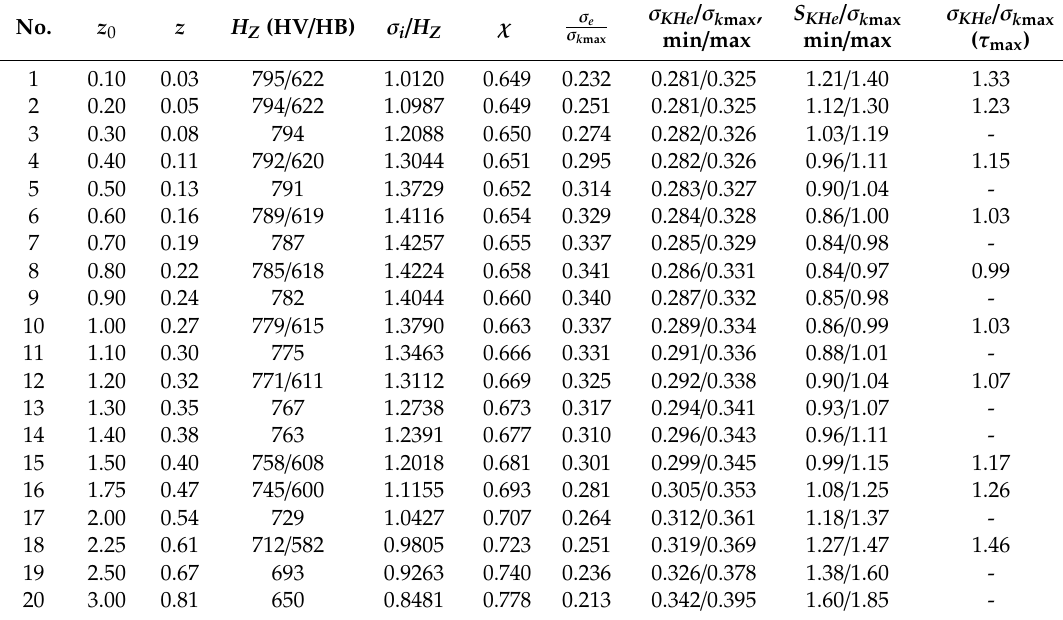
Figure 6. Cross microsection of sample CD-30. Table 3. DCS indicators of sample CD-30